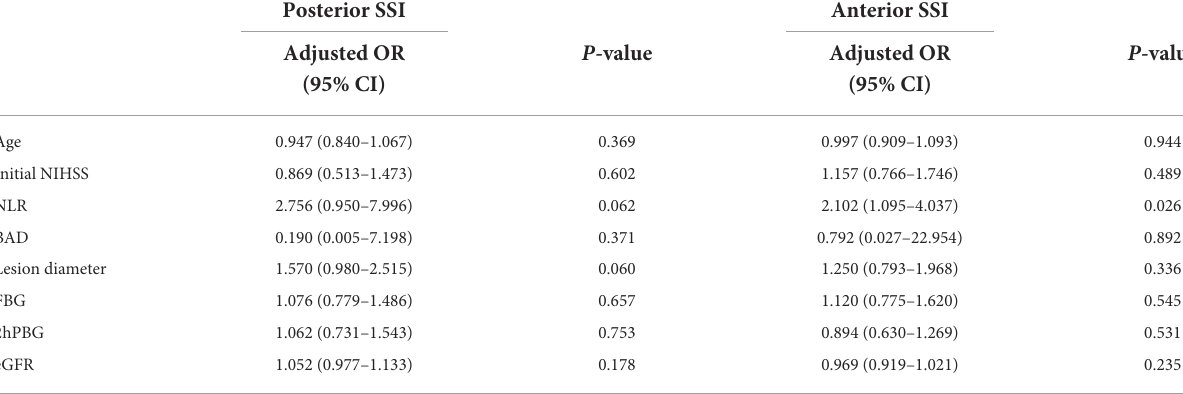
TABLE 5 Logistic regression analysis of factors associated with END in the posterior and anterior SSI